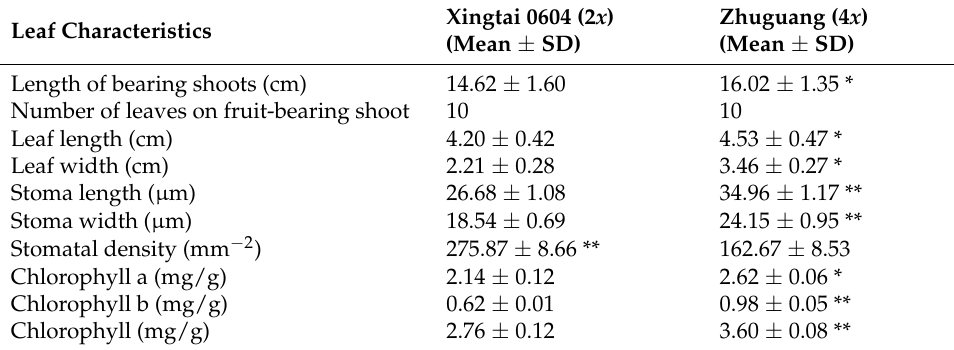
Table 3. Leaf characteristics of ‘Xingtai 0604 (cid:48) and